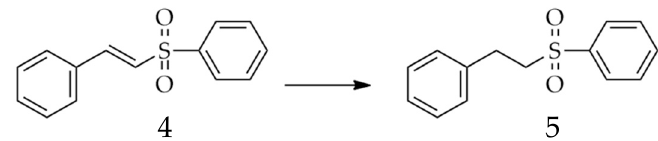
Table 3. Trans-phenyl-styrylsulfone hydrogenation reactions with silica-supported Cu catalysts at 1 Bar of H 2